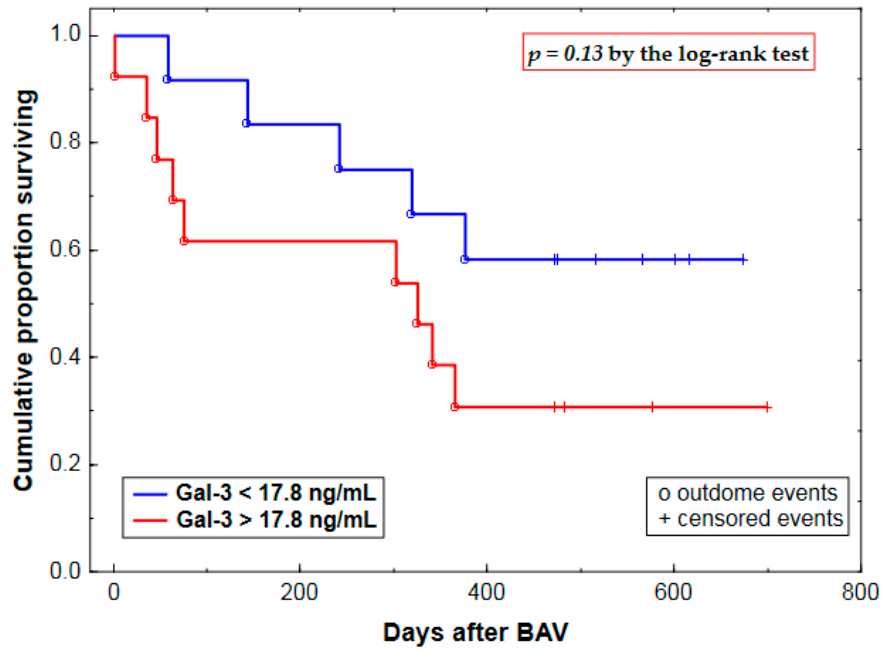
Figure 3. Kaplan–Meier survival curves by pre-procedural plasma galectin-3 (Gal-3) for aortic stenosis patients undergoing balloon aortic valvuloplasty (BAV).